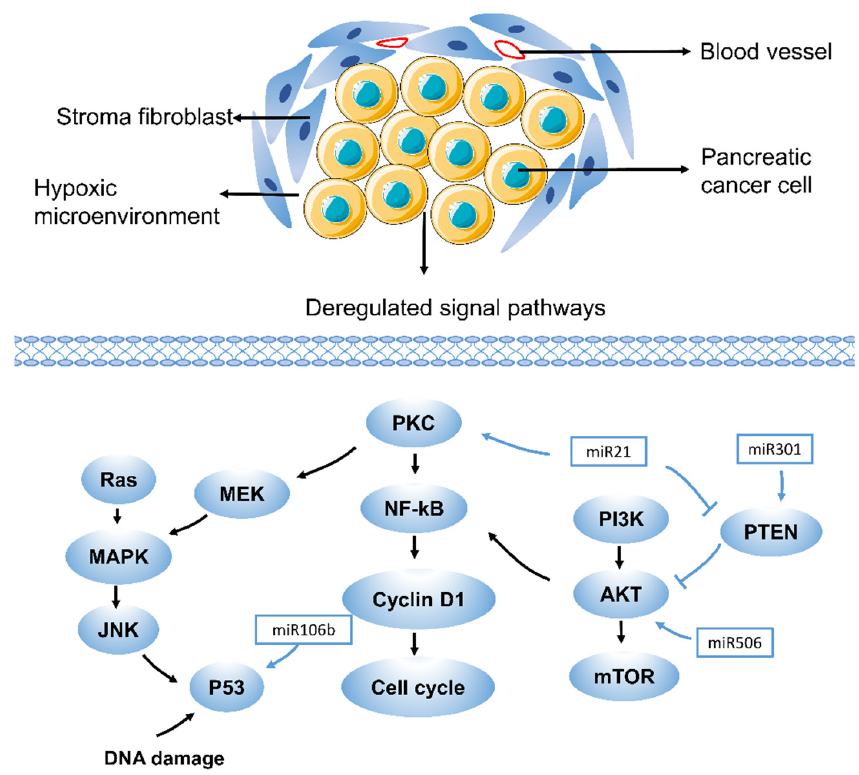
Figure 1. Drug resistance pathways in pancreatic cancer. RAS, rat sarcoma virus oncogene; JNK, Jun N-terminal kinase; NF- K B, nuclear factor- K -gene binding; PKC, Protein kinase C; PTEN, phosphatase and tensin homologue; PI3K, phosphatidylinositol 3-kinase. Drug resistance in pancreatic cancer is caused by various mechanisms, including aberrant gene expression, mutations, and deregulation of key signaling pathways (such as MAPK, Akt, NF- K B, and miRNA-related pathways). Each of these pathways contributes to drug resistance in pancreatic cancer in different ways, which suggests that different therapeutic targets exist. A few representative drug resistance pathways are shown, such as the MAPK, Akt, NF- K B, and miRNA-related